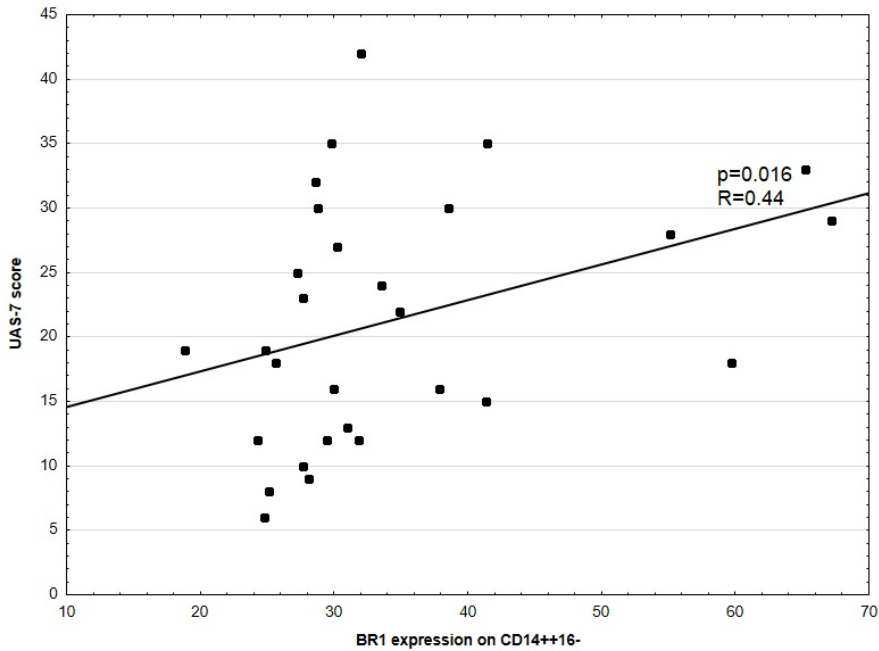
Figure 2. Correlation between UAS-7 score and BR1 expression in CD14 ++ CD16 − cells. Each dot represents one patient.